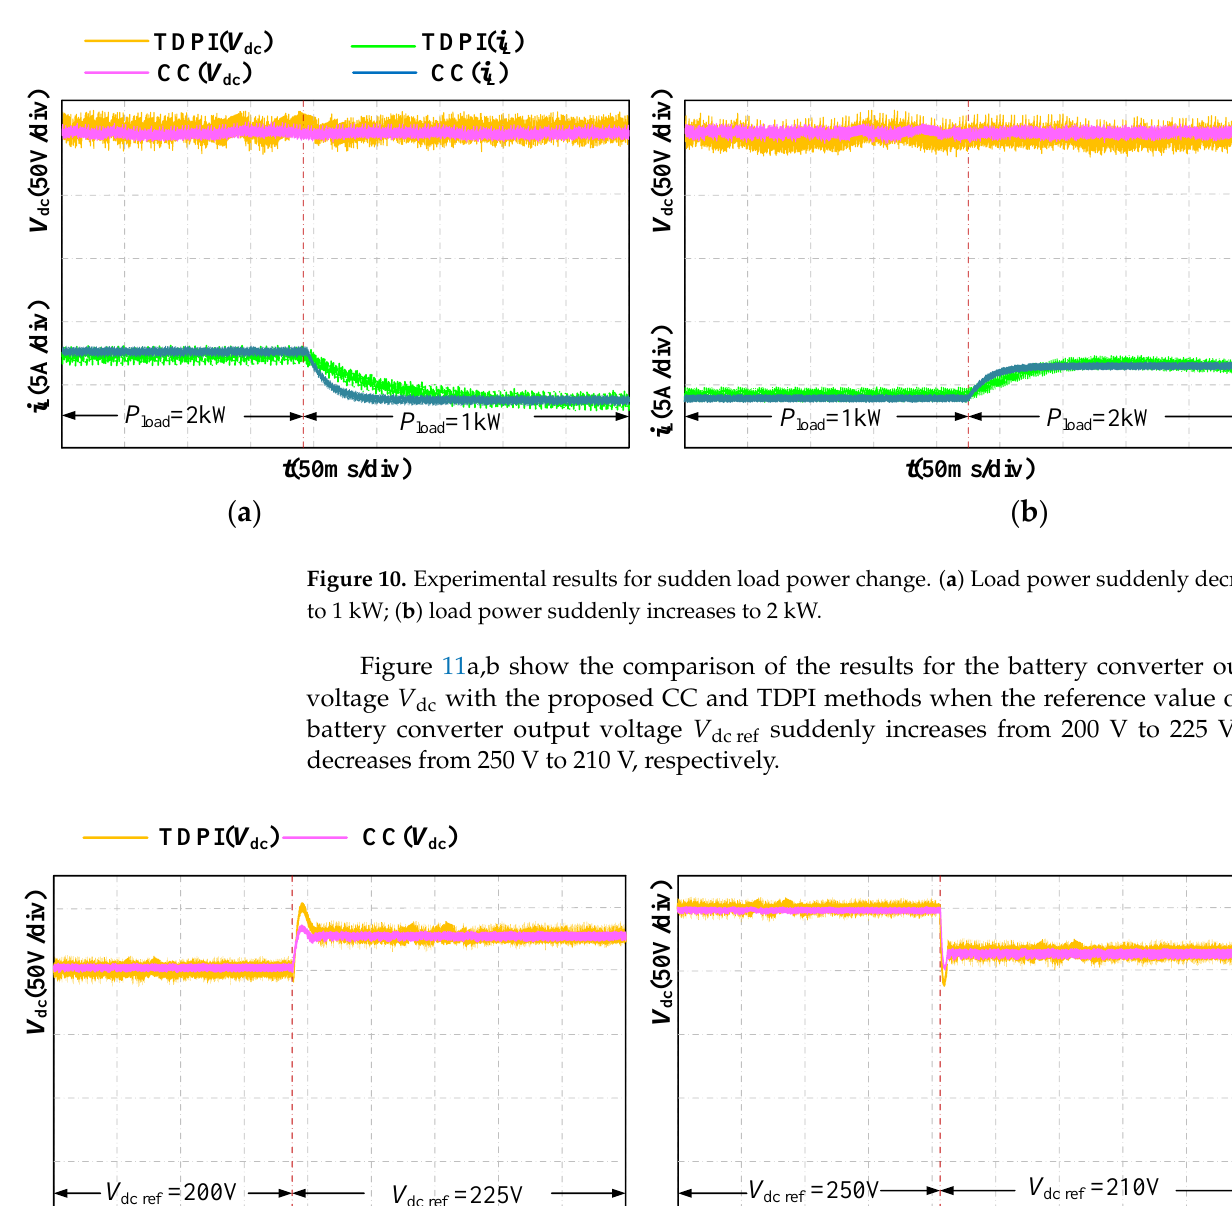
15 of 18 Figure 9. Hardware for the experiment platform.